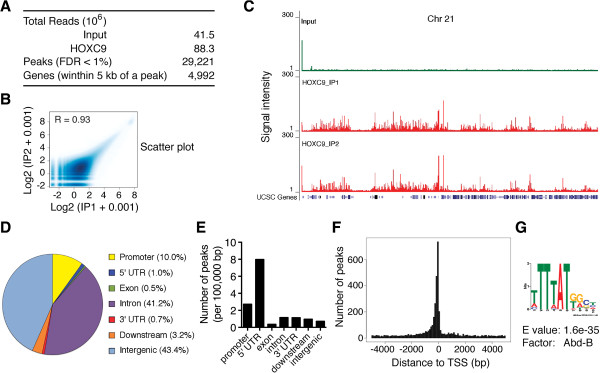
ChIP-seq analysis of HOXC9 genomic distribution. (A) Summary of HOXC9-binding peaks and genes identified by ChIP-seq. (B-C) Scatter plot analysis (B) and ChIP-seq tag profiles of chromosome 21 (C) showing a high correlation between two independent HOXC9 ChIP-seq samples. (D) Pie chart showing genomic distribution of HOXC9-binding peaks relative to RefSeq functional categories including promoters (within 5 kb upstream of TSS), 5’ UTRs, exons, introns, 3’ UTRs, downstream (within 5 kb downstream of the gene), and intergenic regions (outside −5 ~ +5 kb of genes). (E) Bar graph showing the distribution of HOXC9-binding peaks relative to the functional categories after normalization to the size of each category in 100 kb. (F) Histogram showing the distribution of HOXC9-binding peaks relative to the nearest TSS. Peaks were combined in 100 bp. (G) Web logo showing the top enriched motif present in HOXC9 ChIP-seq peaks, which corresponds to the binding site for Abd-B, the Drosophila ortholog of mammalian HOX9-13 paralogs.